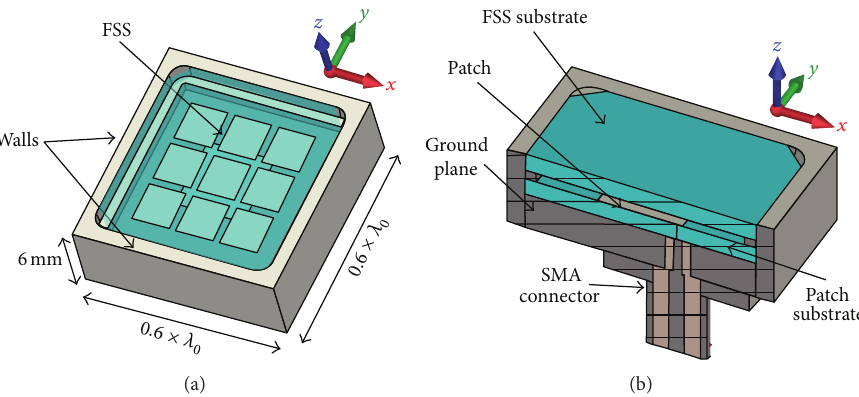
Figure 1: Elementary pixel: (a) perspective view and (b) inside view (cut-plane at the middle along ( 0𝑦 )).